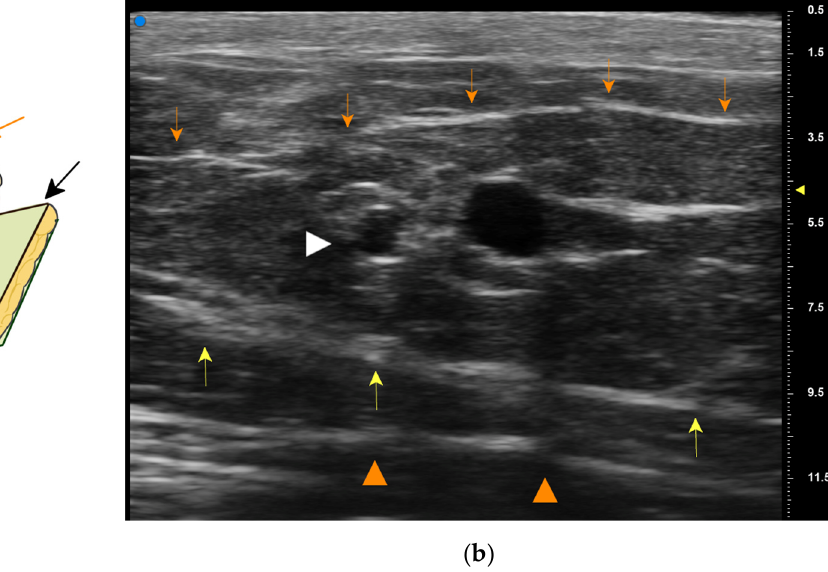
Figure 7. (a) Showing two distinct planes: the superficial fascia (orange arrow) and the Camper fascia (black arrow). ( b ) High-resolution ultrasonographic imaging of the SCIA superficial branch. The superficial branch (white arrow head) is identified between the superficial fascia (orange arrows) and the Camper fascia (yellow arrows). The Scarpa fascia is also distinct (orange arrow heads).